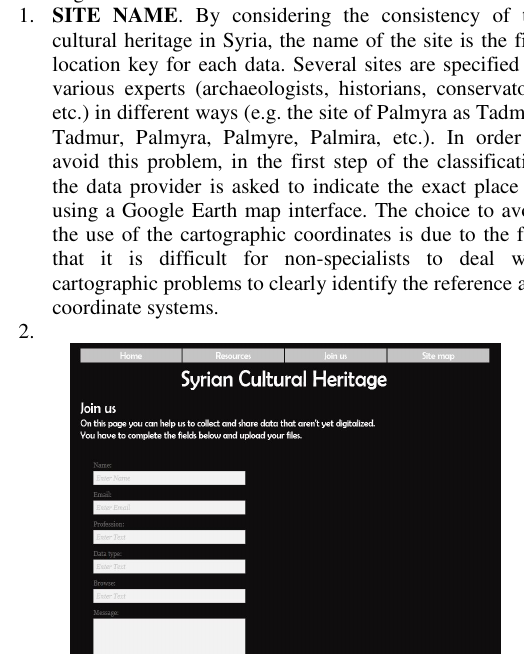
Figure 8. The site of data